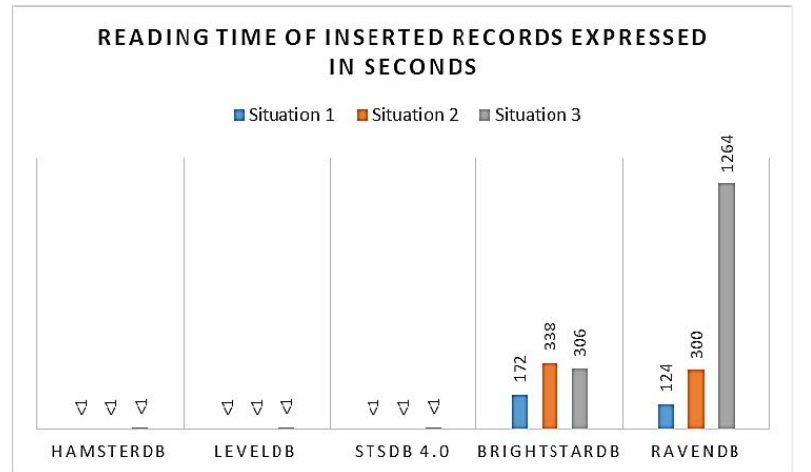
Figure 9 – Reading time of inserted records expressed in seconds